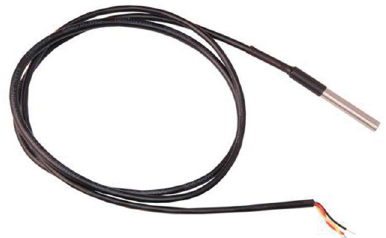
Figure 3: Temperature sensor probe (as adopted from https:// www.med-linket.com/products/temperature/?gclid � Cj0KCQjwyY KUBhDJARIsAMj9lkEILNuL8rZfc7x9BLNb4a3nYZhb-Gw2XWm